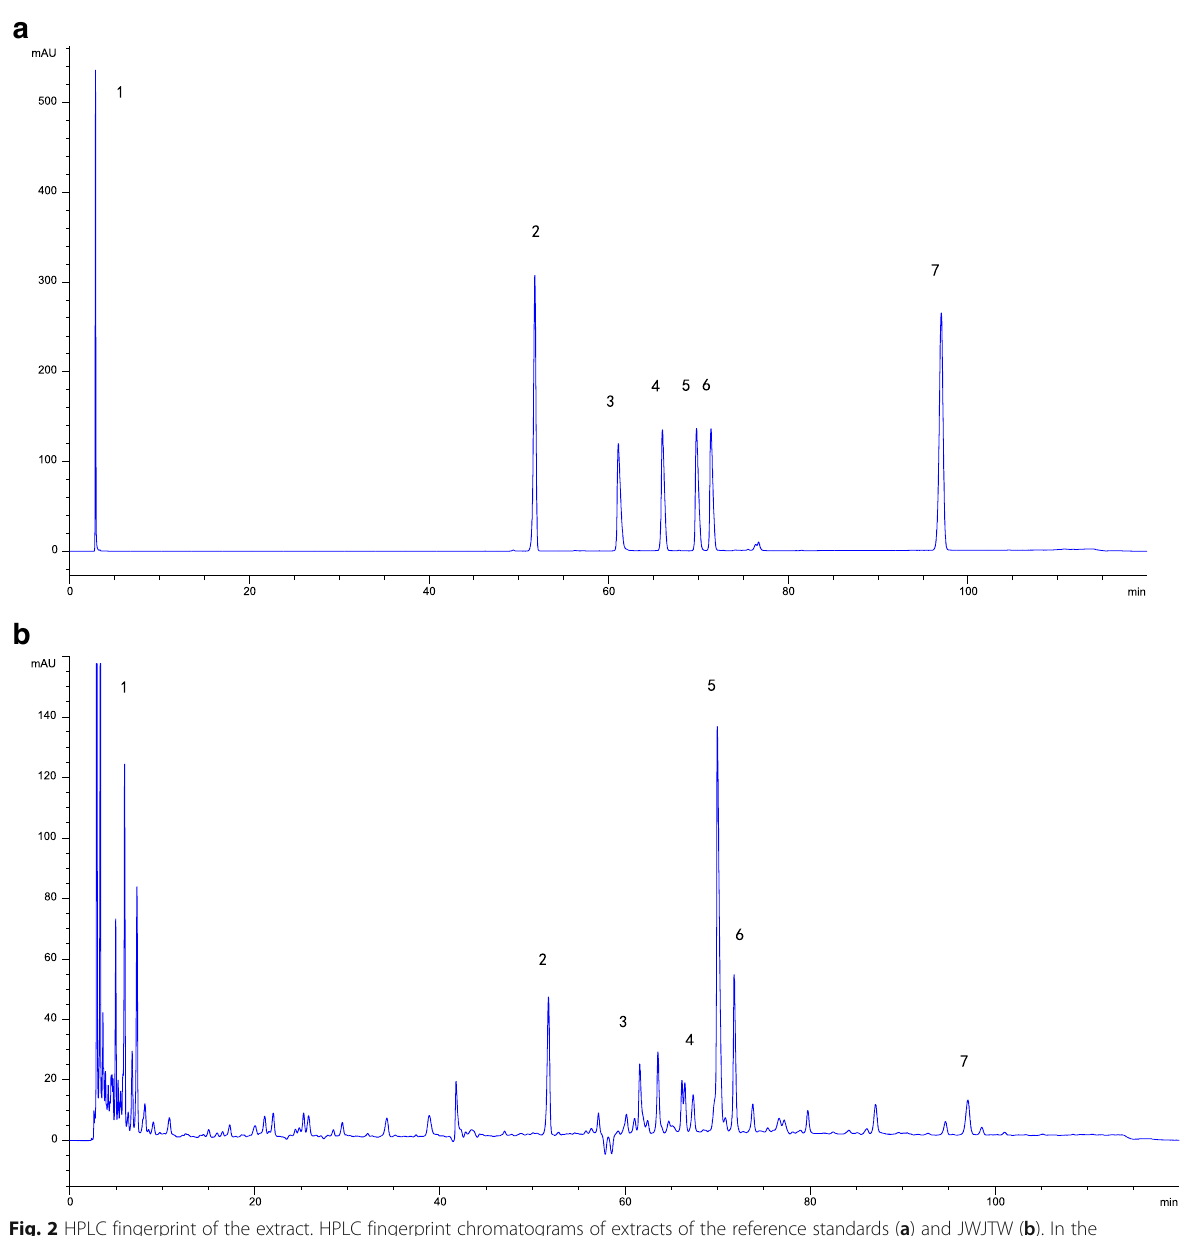
Fig. 2 HPLC fingerprint of the extract. HPLC fingerprint chromatograms of extracts of the reference standards ( a ) and JWJTW ( b ). In the chromatograms: (1) trigonelline (PubChem CID:5570); (2) puerarin (PubChem CID: 5,281,807); (3) coptisine (PubChem CID: 72,322); (4)